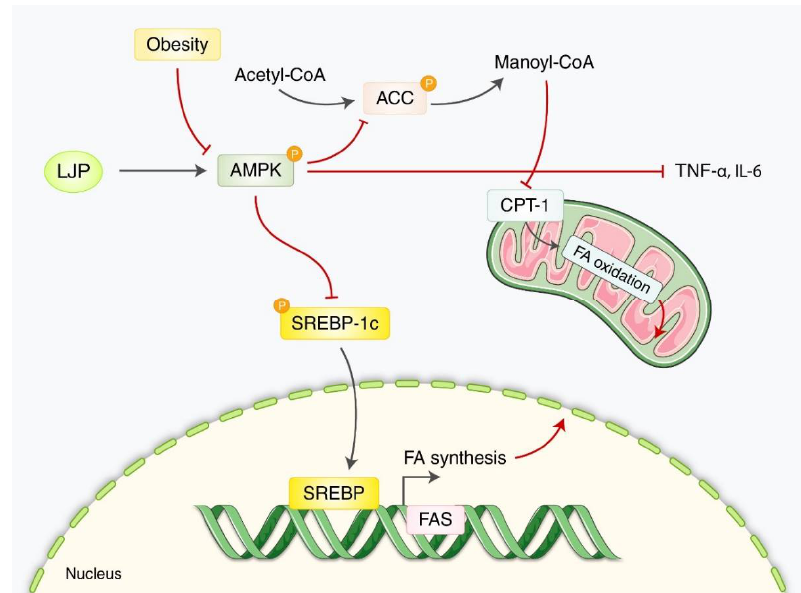
Figure 3. A schematic overview of the principal mechanisms of LJP against obesity . In normal conditions, AMPK upregulates fatty acid oxidation by inhibiting ACC and downregulates FA syn- thesis by inhibiting the dephosphorylation of transcription factor SREBP-1c. Additionally, obesity inhibits the AMPK, increasing the FA synthesis and reducing FA oxidation. LJP revered the obesity- induced FA synthesis and increased the AMPK activity and FA oxidation. ACC: acetyl coenzyme A carboxylase, AMPK: AMP-activated protein kinase, CPT-1: carnitine palmitoyl transferase 1, FAS: fatty acid synthase, SREBP-1c: sterol regulatory element-binding protein